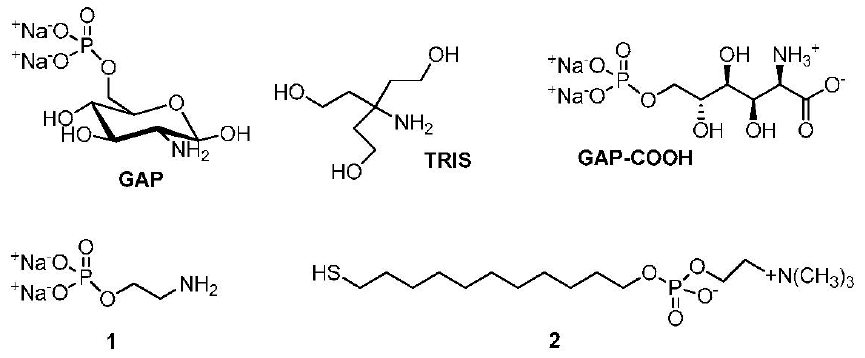
Figure 1. Compounds discussed in this work.